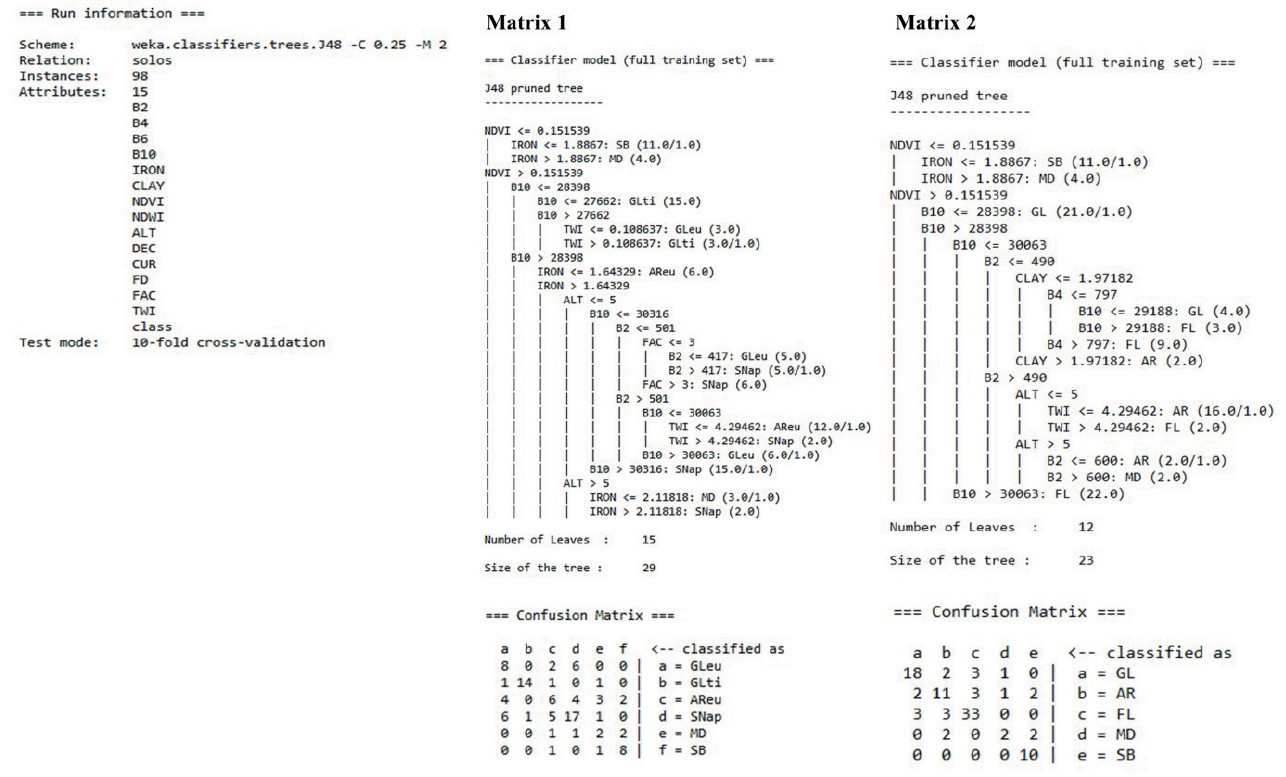
Figure 5. Result of processing the data matrices in WEKA software (generated classification models and confusion matrices). B2: Band 2 of the Landsat image; B4: Band 4 of the Landsat image; B6: Band 6 of the Landsat image; B10: Band 10 of the Landsat image; IRON: Iron oxide index; CLAY: Clay minerals index; NDVI: Normalized difference vegetation index; NDWI: Normalized difference water index; ALT: Elevation; DEC: Slope; CUR: Curvature; FD: Flow direction; FAC: Flow accumulation; TWI: Topographic wetness index; GLeu: Eutric Gleysol ( Gleissolo Háplico ); GLti: Thionic Gleysol ( Gleissolo Tiomórfico ); AReu: Eutric Arenosol ( Neossolo Quartzarênico ); SNap: Abruptic Solonetz ( Planossolo Nátrico ); GL: Soils with gleyc characteristics; AR: Soils with sand texture; FL: Soils with fluvic materials; MD: Mobile dunes; SB: Sand